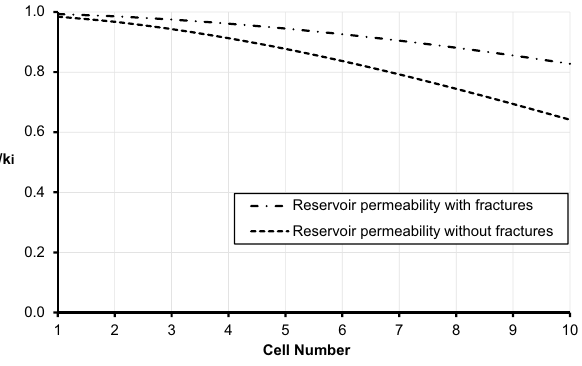
Fig. 11 Permeability alteration by asphaltene deposition in fractured and non-fractured